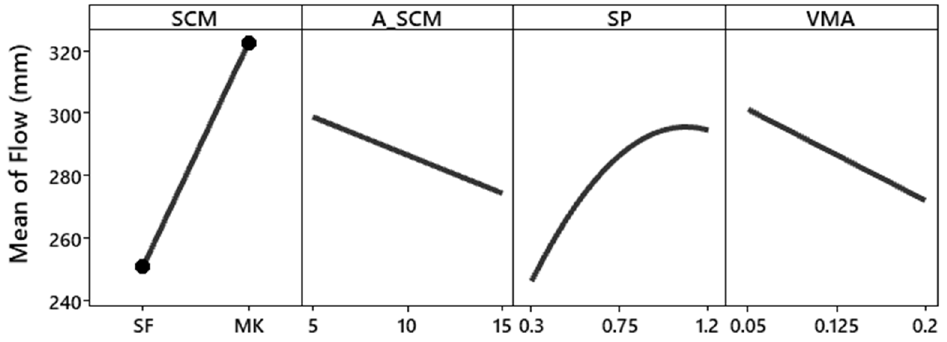
Figure 2. The main effects plot for slump flow.